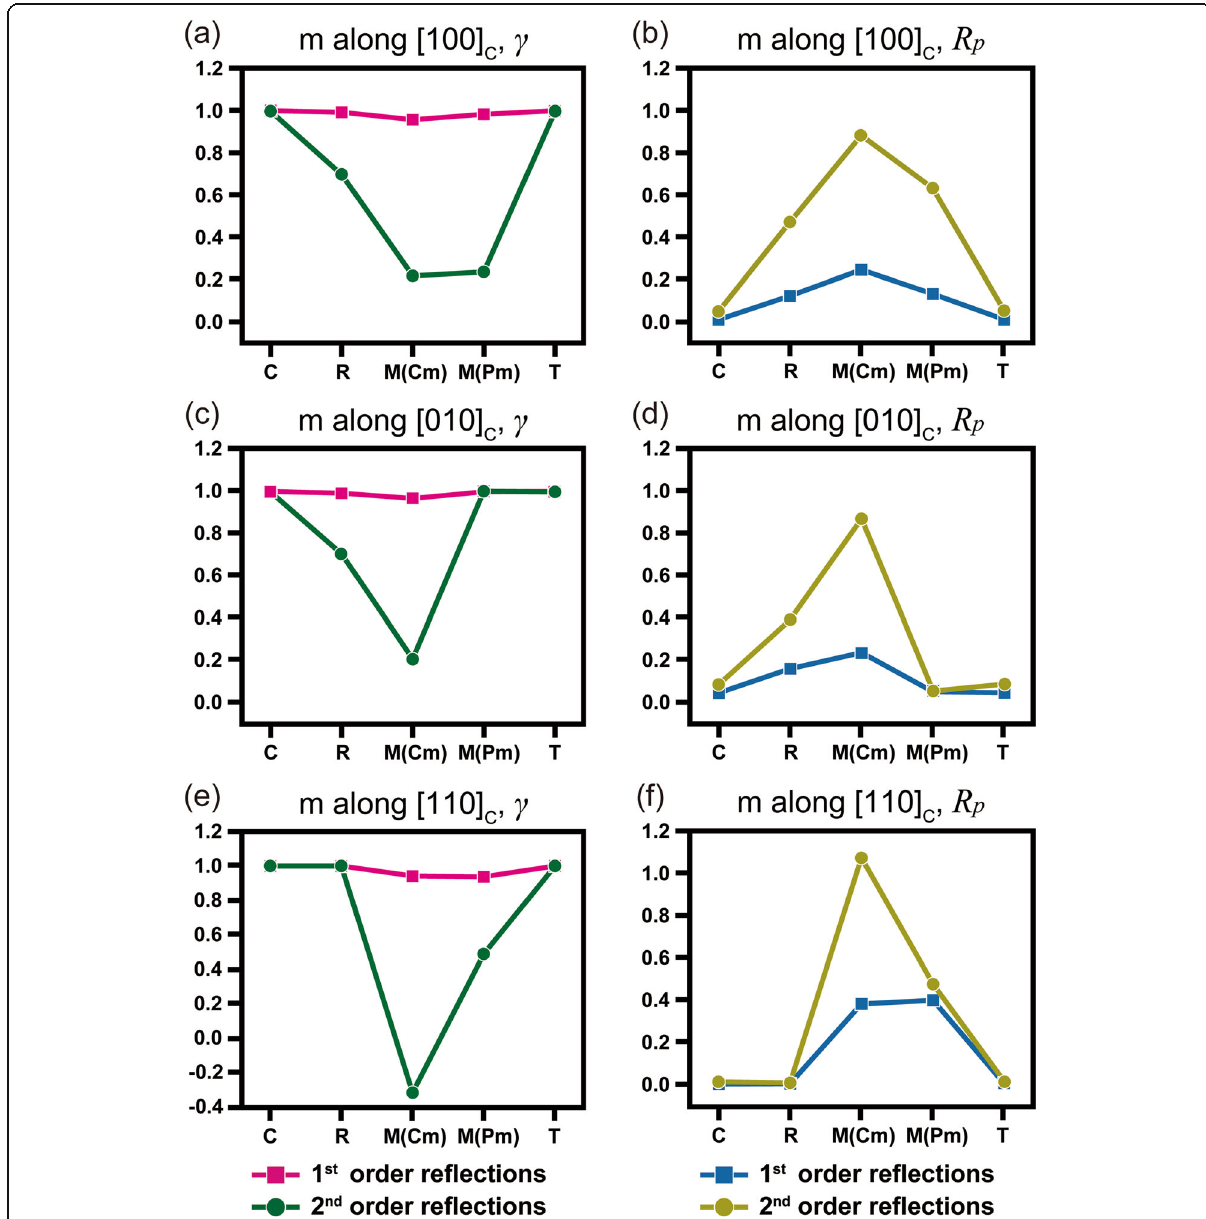
Fig. 6 Quantified symmetry element for simulated CBED patterns of